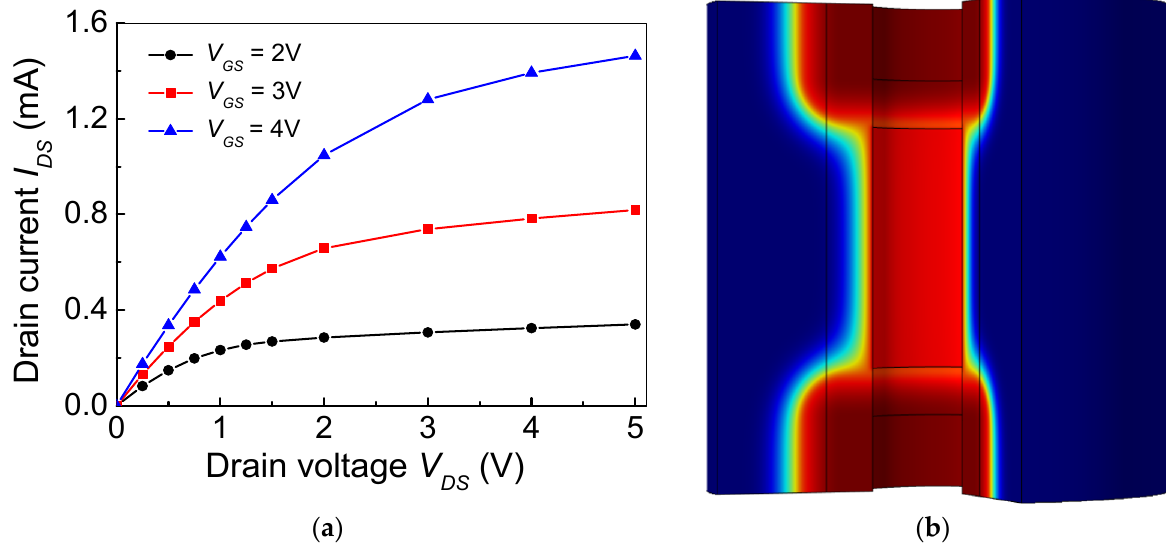
Figure 7. ( a ) Output curves of vertical MOSFET; ( b ) channel of vertical MOSFET in on-state. Table 1. Electrical parameters of the Vertical MOSFET.